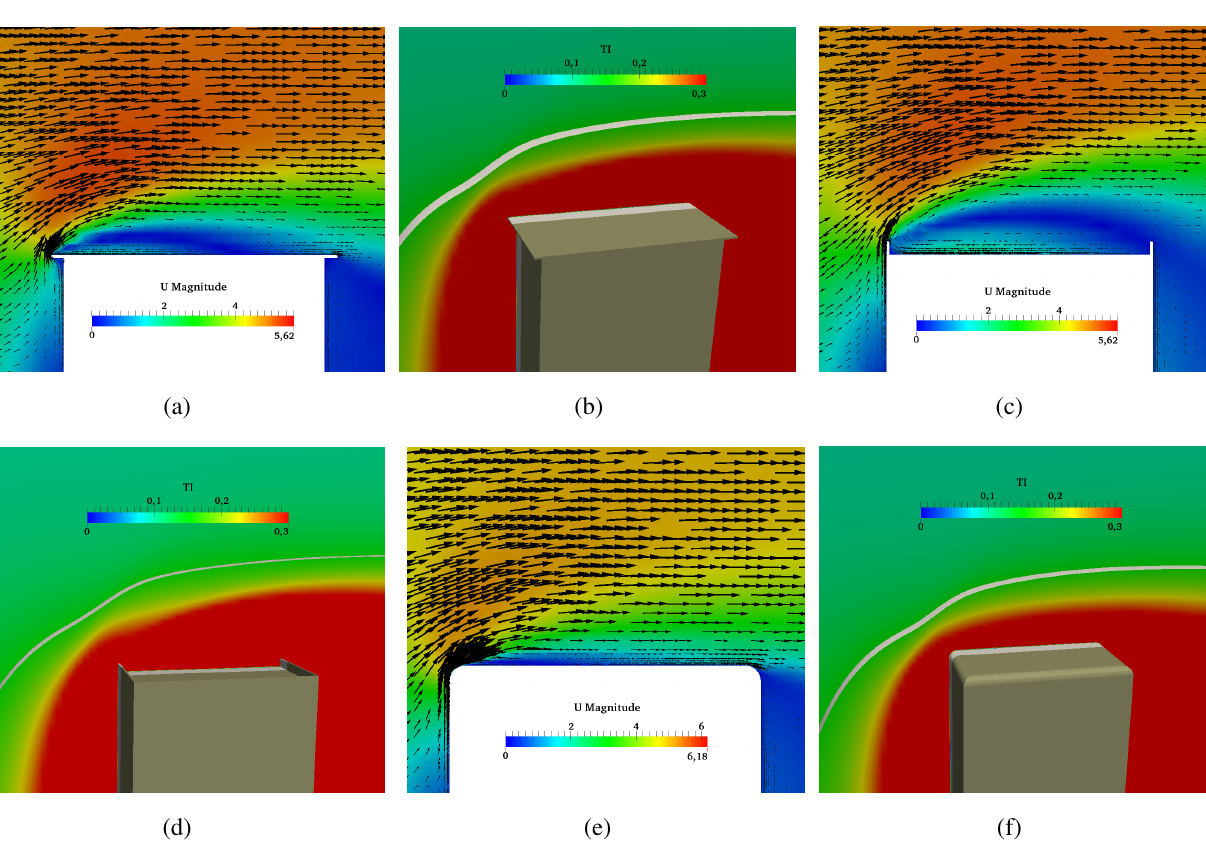
Figure 21. Comparison of U and T I fields on the roof for the different roof shapes investigated. ( a ) U field cantilever; ( b ) T I field cantilever; ( c ) U field railing; ( d ) T I field railing; ( e ) U field curved edge; ( f ) T I field curved